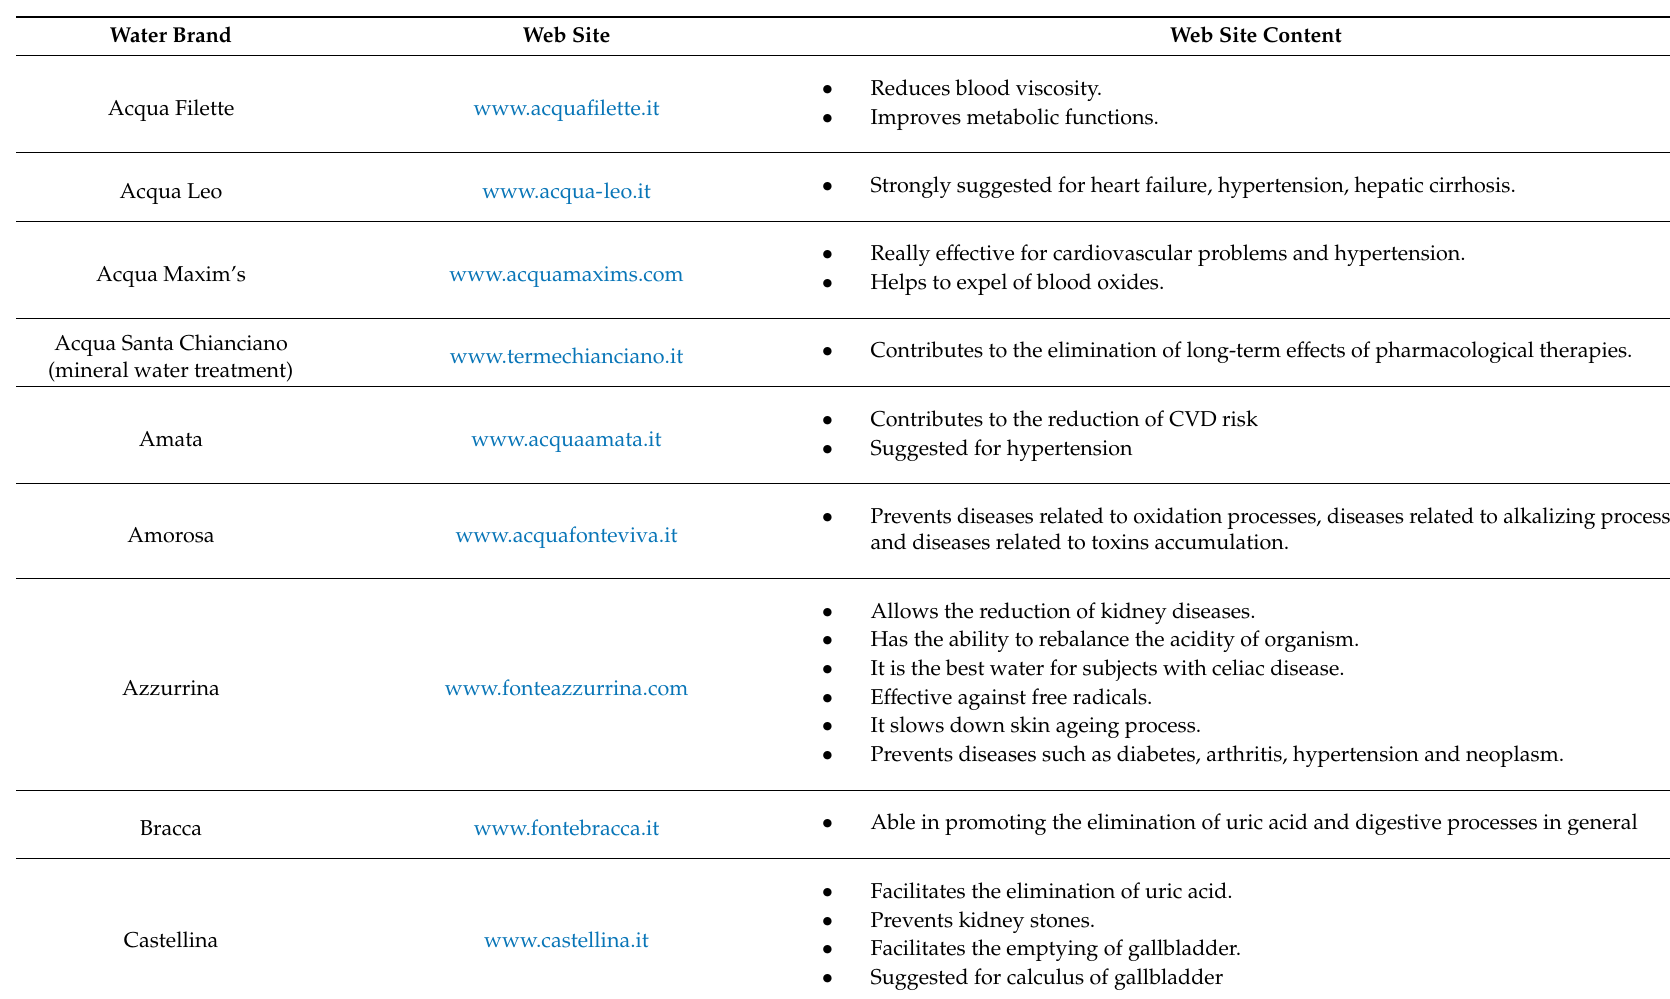
Table 1. Wording included in website of the selected bottled water ( n =